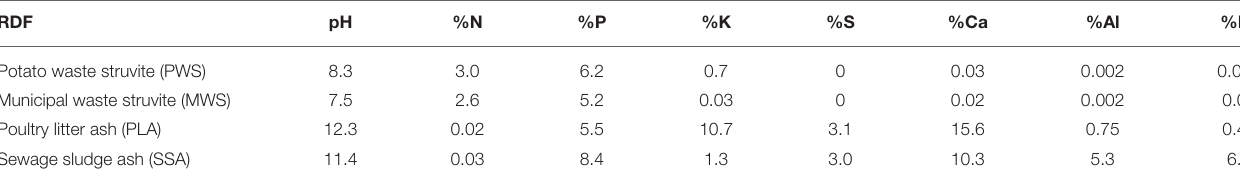
TABLE 1 | Nutrient content of bio-based fertilizers.